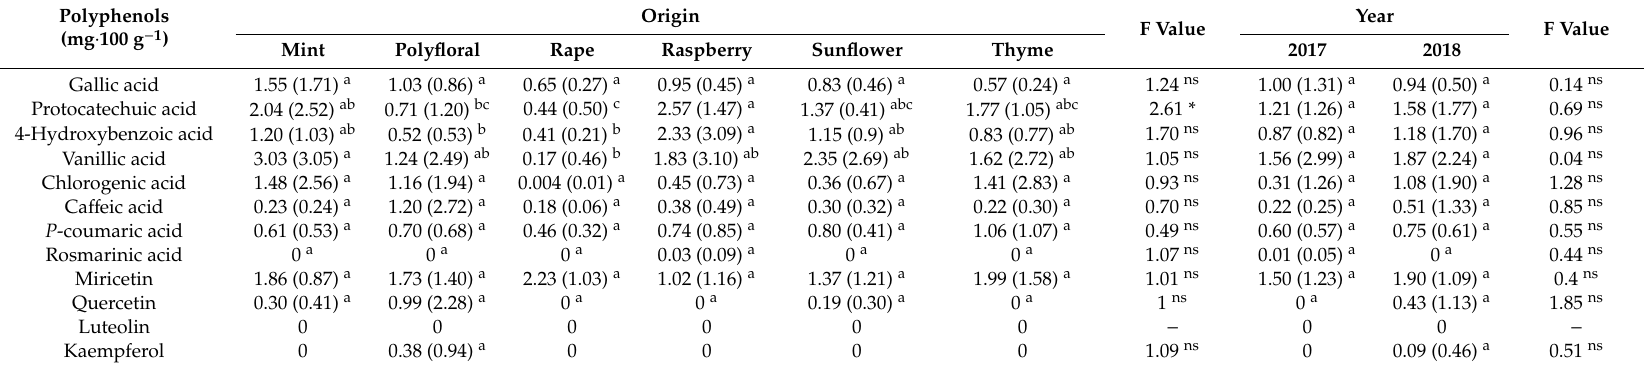
Table 4. Polyphenols content for di ff erent types of Romanian honey. Mean values and standard deviation in